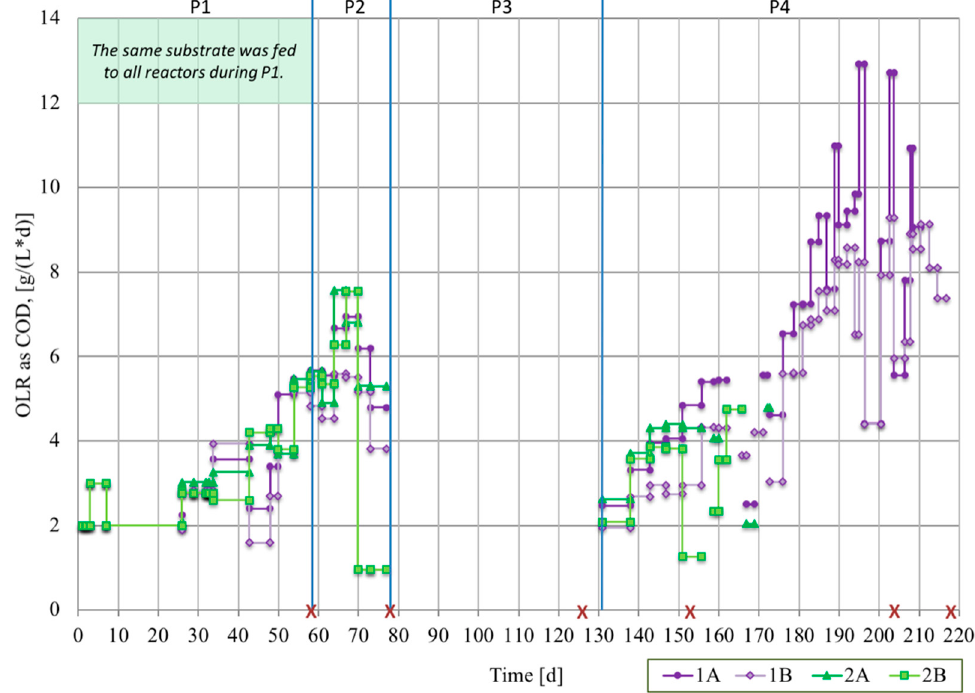
Figure 1. Organic loading rate (OLR) of upflow anaerobic sludge blanket (UASB) reactors 1A, 1B, 2A, and 2B, expressed as chemical oxygen demand (COD), per reactor volume and time (g/L/d). Average OLR (horizontal line) between time points (dots). The blue lines indicate the changes between operating periods 1–4 (P1–P4), described in Table 1. Time points of microbial sampling are marked with red crosses.